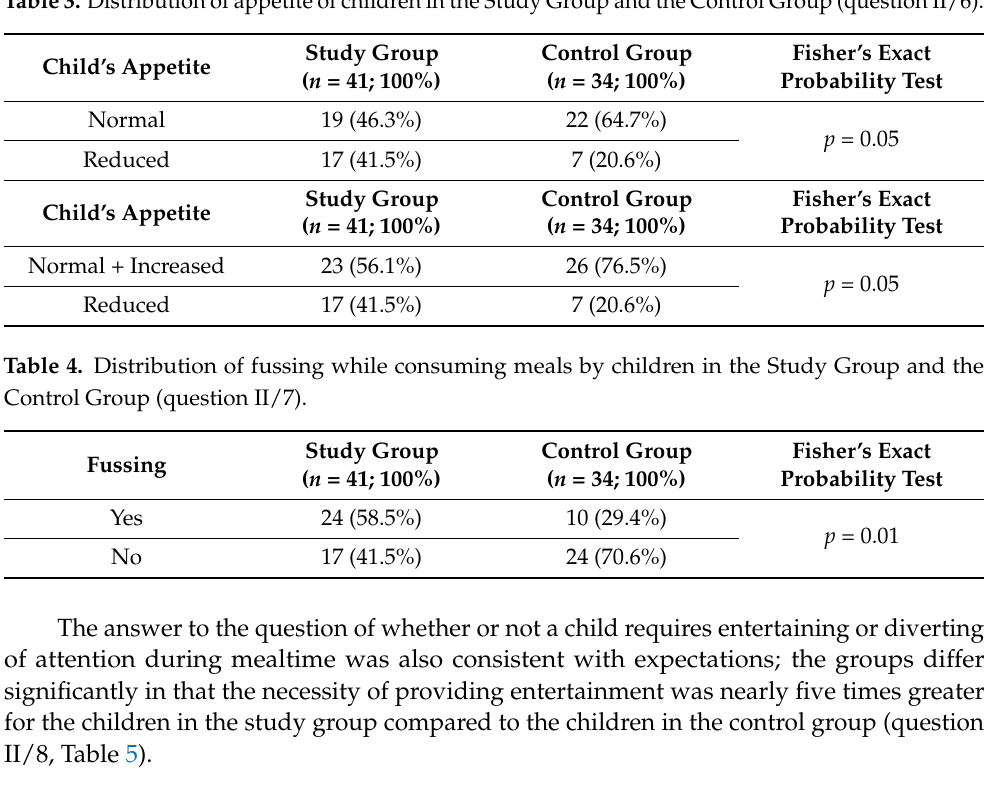
Table 5. Distribution of entertaining activities during meal consumption for children in the Study Group and the Control Group (question II/8).